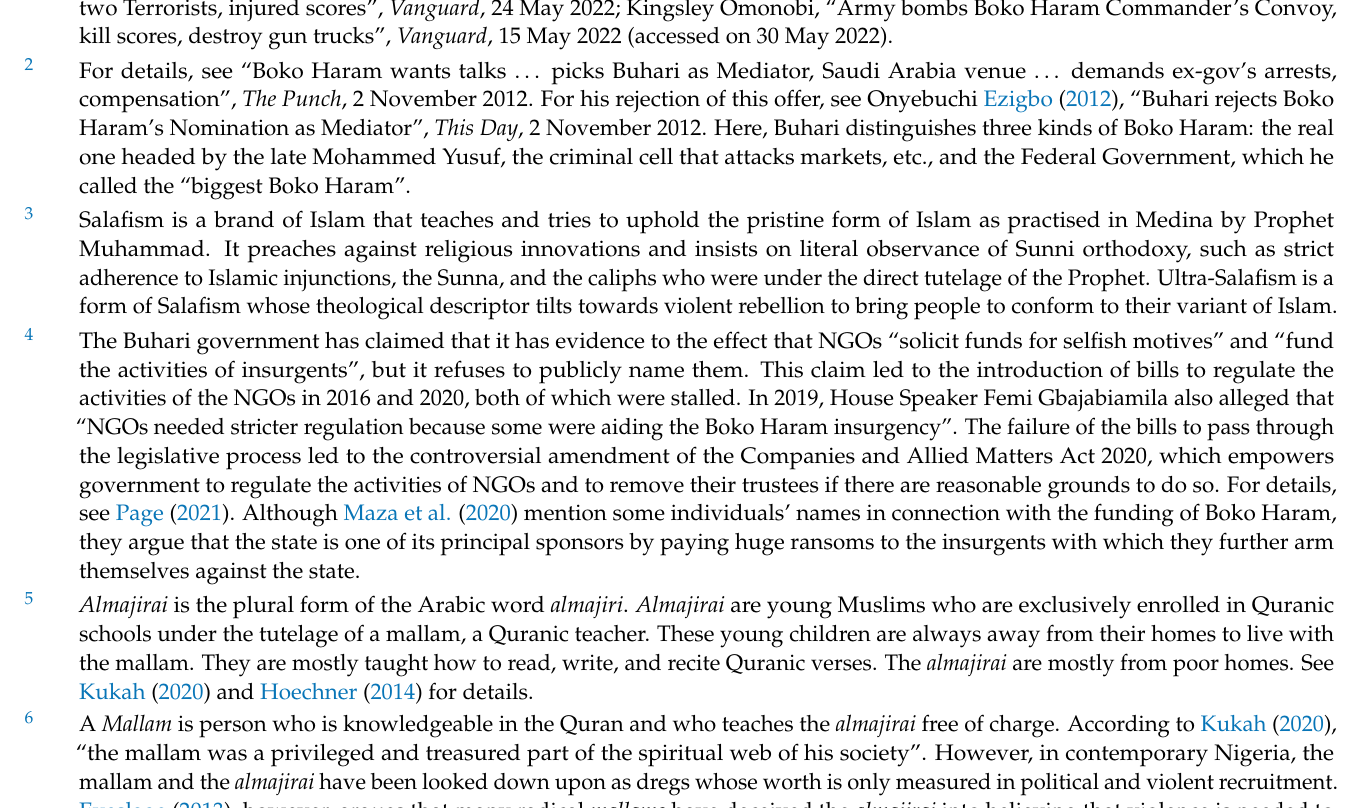
Kukah (2020) and Hoechner (2014) for